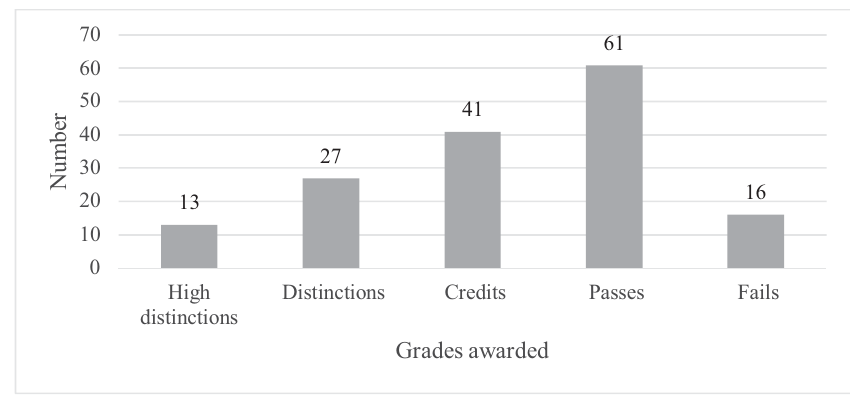
FIGURE 1 Outcomes achieved in terms of overall grades of 45 ATSI students over three semesters in 2016 at Bond University (Bond University, 2017a).